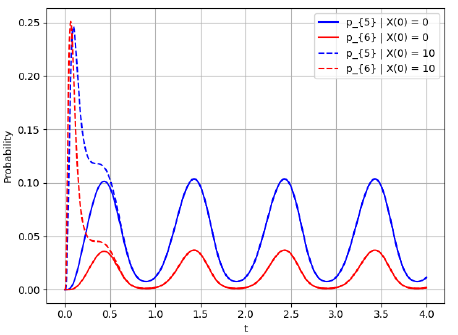
Figure 14. Probability p 5 ( t ) , p 6 ( t ) for t ∈ [ 0,4 ] ; this figure shows the rate of convergence for N =